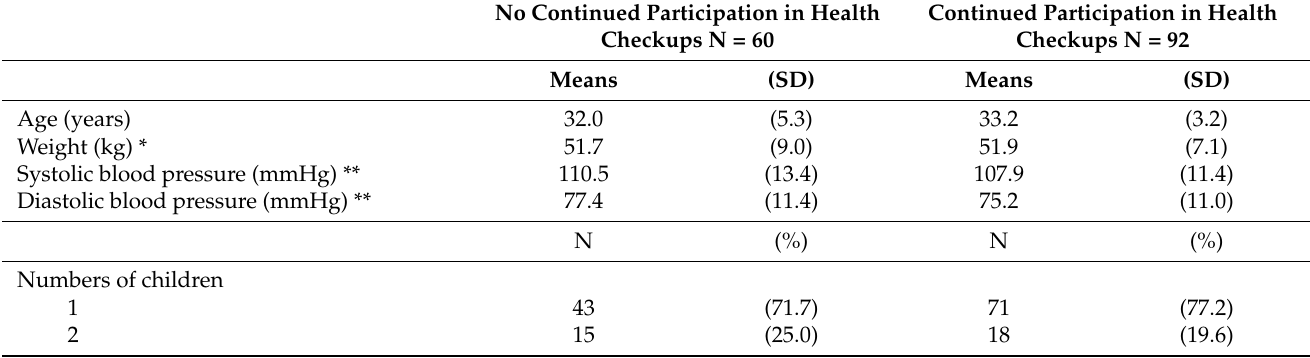
Table 1. Participants’ characteristics (N =